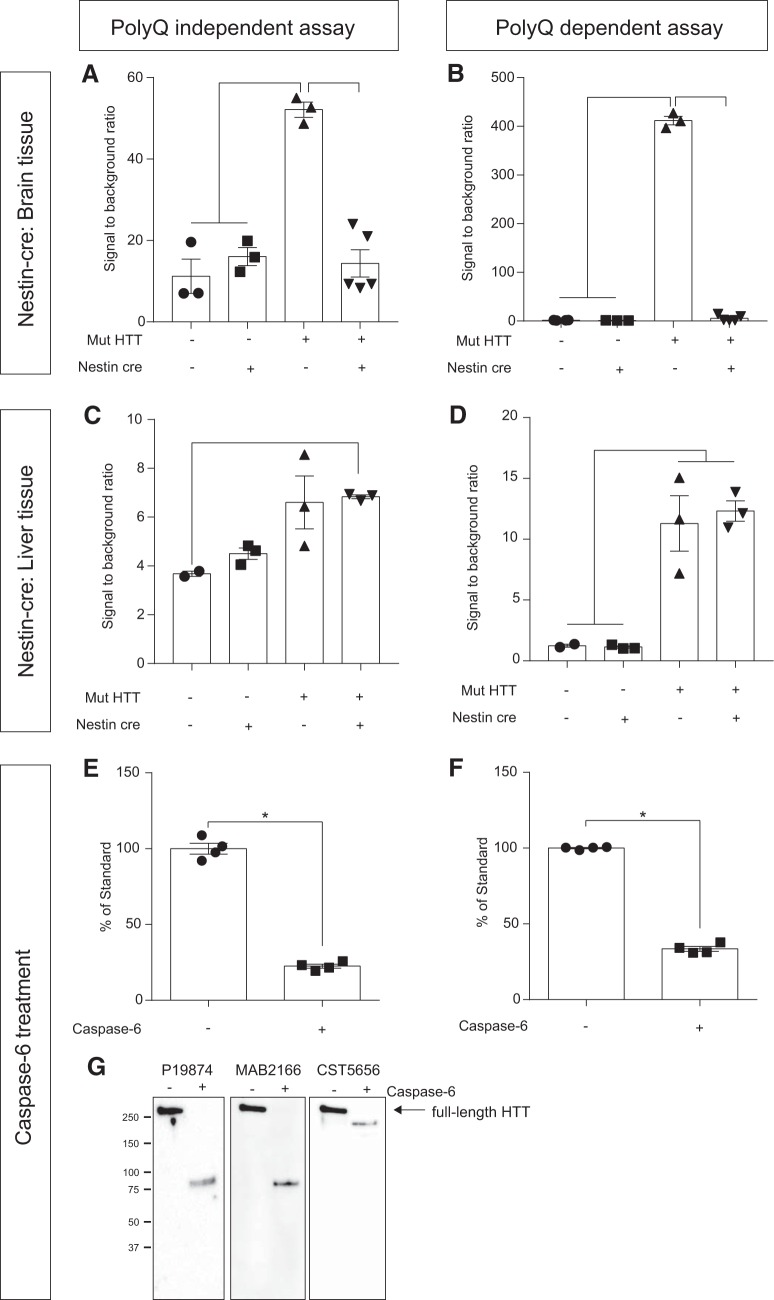
AlphaLISA signal changes on mutant HTT deletion in mice. BACHD mice have been crossed with Nestin-Cre mice, allowing Cre-dependent excision of mutant HTT from all neurons. Brain tissue lysates from BACHD × Nestin-Cre mice were analyzed with the polyQ-independent (A) and -dependent (B) assay and reported as signal-to-background ratios. HTT levels in the BACHD group were significantly different from the levels in the two WT groups as well as in the BACHD × Nestin-Cre mice in both the polyQ-independent and polyQ-dependent assay, indicating that the AlphaLISA signal is sensitive to genetic manipulations of HTT levels (one-way ANOVA with Tukey’s post hoc test BACHD in the polyQ-independent assay: F(3,10) = 30.46, p < 0.0001; BACHD in the polyQ-dependent assay: F(3,11) = 2410, p < 0.0001). As a control, liver tissue lysates from BACHD × Nestin-Cre mice were analyzed with the polyQ-independent (C) and -dependent (D) assay. In these samples, the polyQ-independent assay showed increased HTT levels in BACHD-NestinCre compared to WT (one-way ANOVA with Tukey’s post hoc test F(3,7) = 5.832, p = 0.0256; C). In the polyQ-dependent assay, HTT levels in both BACHD and BACHD-NestinCre samples were statistically different from HTT levels in WT and NestinCre mice (one-way ANOVA with Tukey’s post hoc test F(3,7) = 20.36, p = 0.0008), but not different between each other (D). Changes in the AlphaLISA signal on treatment of purified HTT expressing 32Q with active caspase-6 were measured with the polyQ-independent (E) and -dependent (F) assay. An aliquot from the same reaction was processed for Western blot analysis using the same antibodies as in the assays (G) and shows HTT proteolytic fragmentation. The significant decrease of full-length HTT in the AlphaLISA signal in samples treated with caspase-6 was verified using students t test. Data are presented as mean ± SEM.